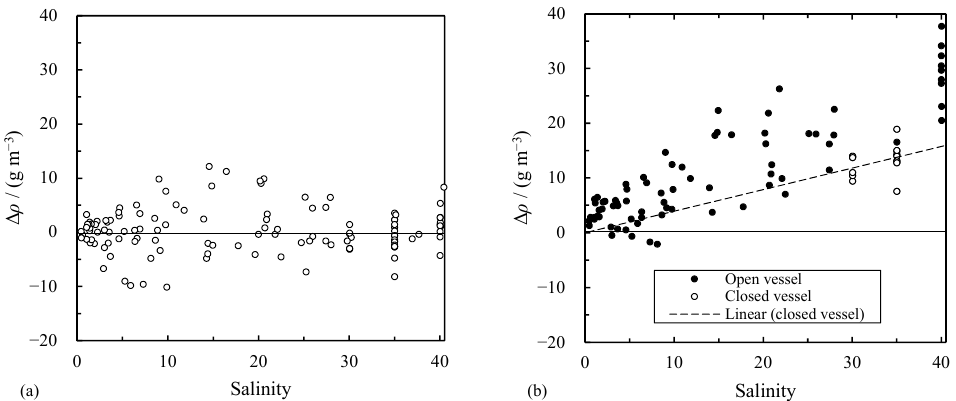
Figure 12. Deviation of densities obtained from standard seawater using a magnetic float densimeter by Millero et al. (a) The deviation of the normalized densities of Millero et al. (JPOTS, 1981c, pp. 51–56) from TEOS-10 (i.e. Millero et al. minus TEOS-10) suggest that TEOS-10 is well fitted to it. (b) The deviation of the original densities of Millero et al. (1976) (i.e. Millero et al. minus DSR) suggest a deviation that systematically increases with salinity. The density uncertainty calculated using the accuracy and reproducibility claimed by Millero et al. (1976) is 2gm − 3 and is significantly exceeded by most of the